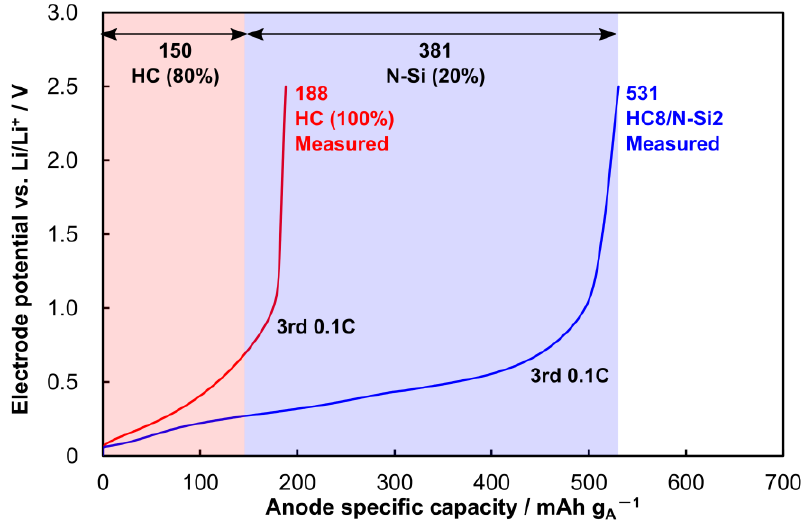
Figure 3. Delithiation curves for the HC and HC8/N-Si2 anodes, and the specific capacity assignment of HC and N-Si to that of the HC8/N-Si2 composite.